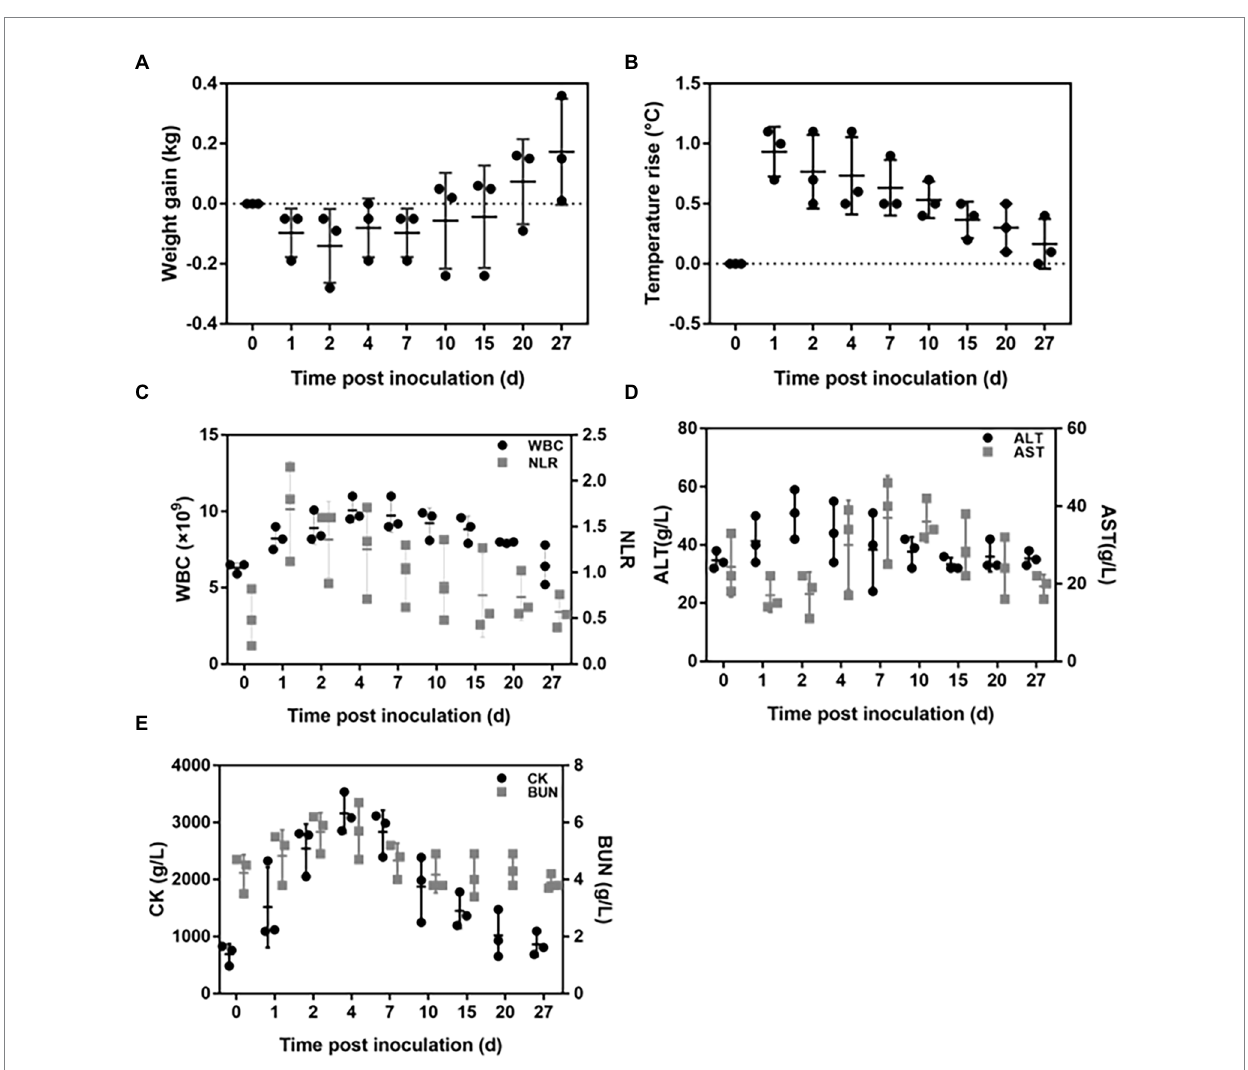
FIGURE 3 Dynamic changes in both the physiological and biochemical indicators after Candida albicans SC5314 inoculation in rabbits. (A) Body weight; (B) Body temperature; (C) White blood cell (WBC) count and neutrophil lymphocyte ratio (NLR); (D) Plasma alanine aminotransferase (ALT) and aspartate aminotransferase (AST); (E) Plasma blood urea nitrogen (BUN), and phosphocreatine kinase